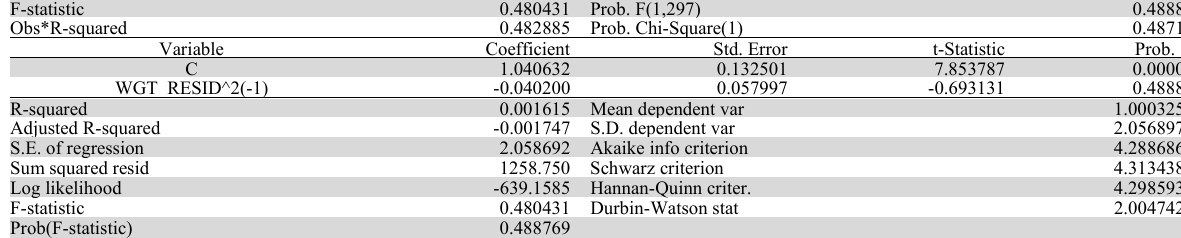
Exhibit the Post Estimation Model Output of Residual Diagnostics by ARCH LM-Test Using Least Squares Method